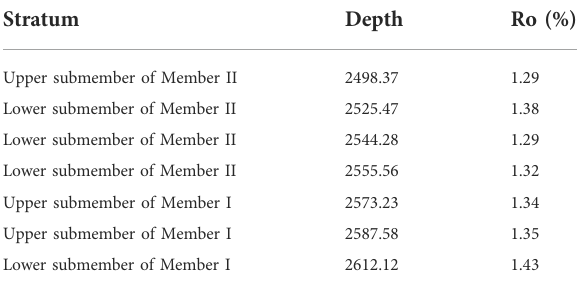
TABLE 1 Analysis results of organic matter maturity of Lianggaoshan Formation shale in Well TYX. Stratum